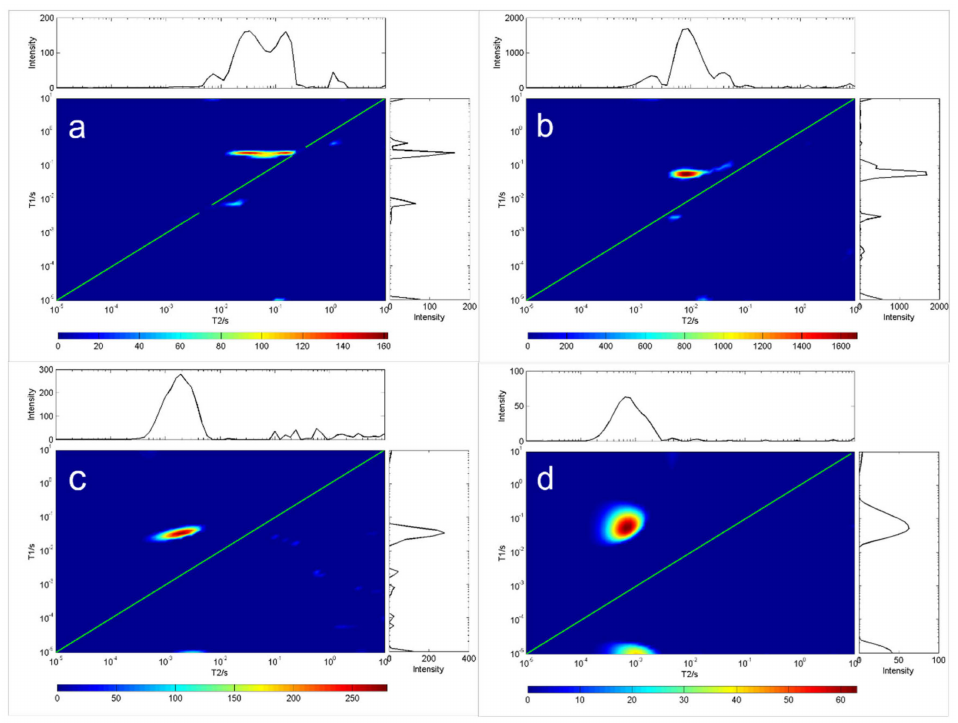
Figure 3. T 1 - T 2 distribution of four oil samples at room temperature (20 ◦ C). In each chart, the green line indicates the T 1 = T 2 line. ( a ) C 21 H 42 O 4 , ( b ) C 24 H 47 NO 4 , ( c ) C 6 H 14 O 5 , ( d ) C 30 H 62 O 21